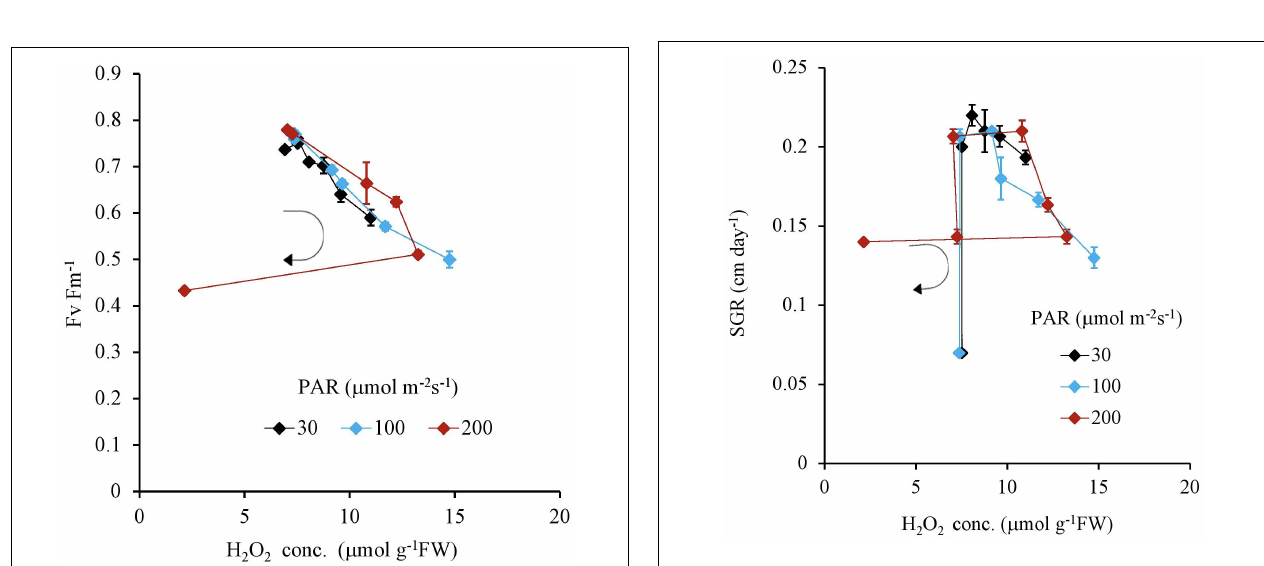
FIGURE 5 | The relation between H 2 O 2 and Fv Fm - 1 of plant tissues after 7 days as a function of Fe concentration in water and PAR intensities. The round arrow indicates the variational trend with increasing Fe concentration. Vertical bars indicate the standard deviation.